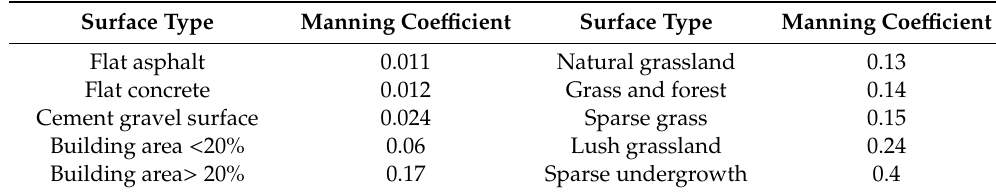
Table 3. Surface Manning coe ffi cient.